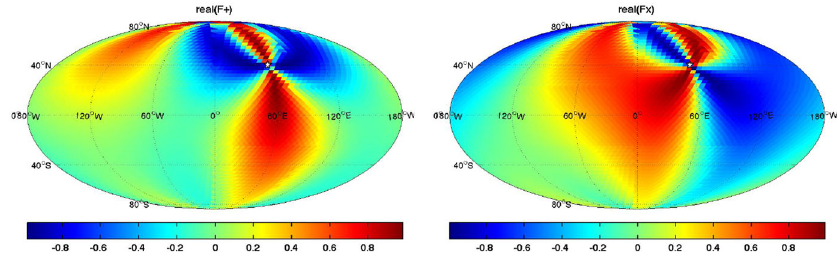
( ˆ n ) , R × ( ˆ n ) , for one-way tracking doppler doppler